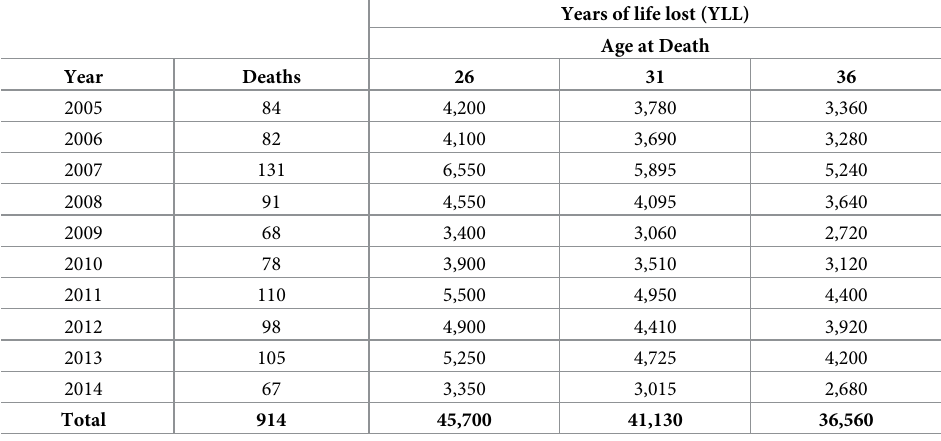
Table 7. Human rabies deaths in Viet Nam and YLL or DALYs from 2005 to